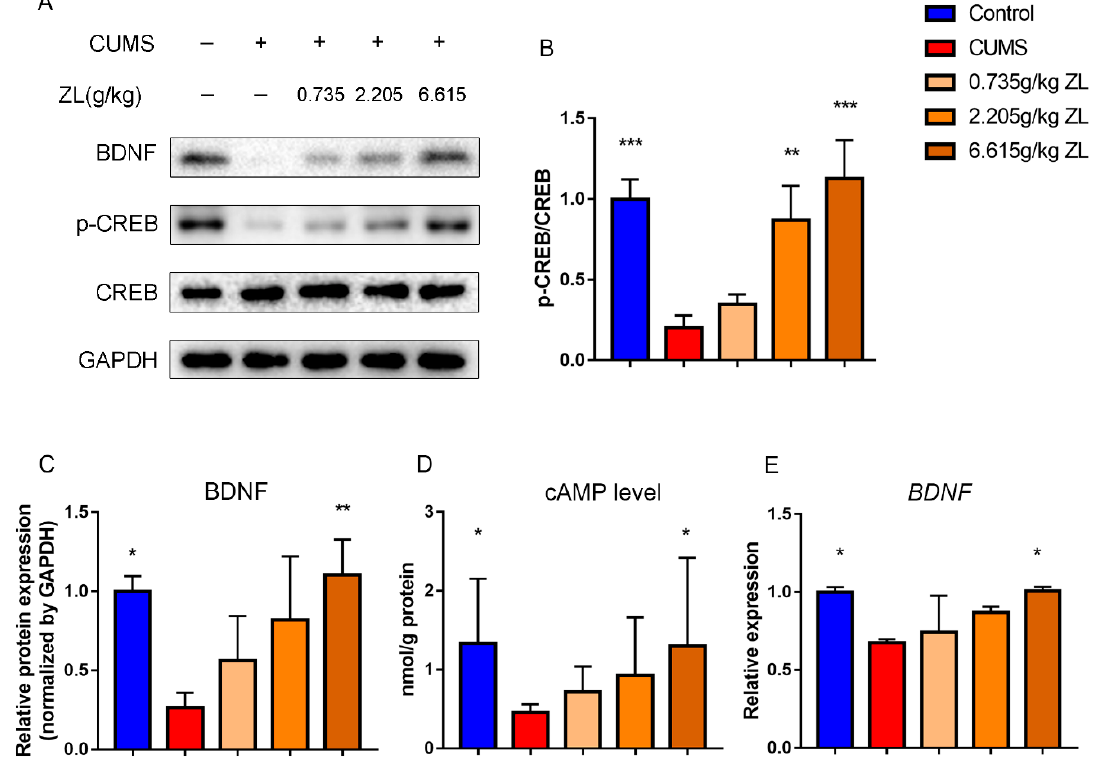
Figure 6. ZL activated cAMP-CREB-BDNF signaling. ( A – C ) Protein expressions of BDNF, p-CREB and CREB in the hippocampus at the end of experiment determined by western blotting. Quantified protein level was normalized to that of GAPDH using densitometry ( n = 3). ( D ) cAMP levels in the rat hippocampus determined by ELISA ( n = 10). ( E ) Relative gene expressions of BDNF in the rat hippocampus quantified by qPCR ( n = 3). GAPDH was used as the loading control. All data are represented as mean ± SD. * p < 0.05, ** p < 0.01, and *** p < 0.001 versus CUMS group.